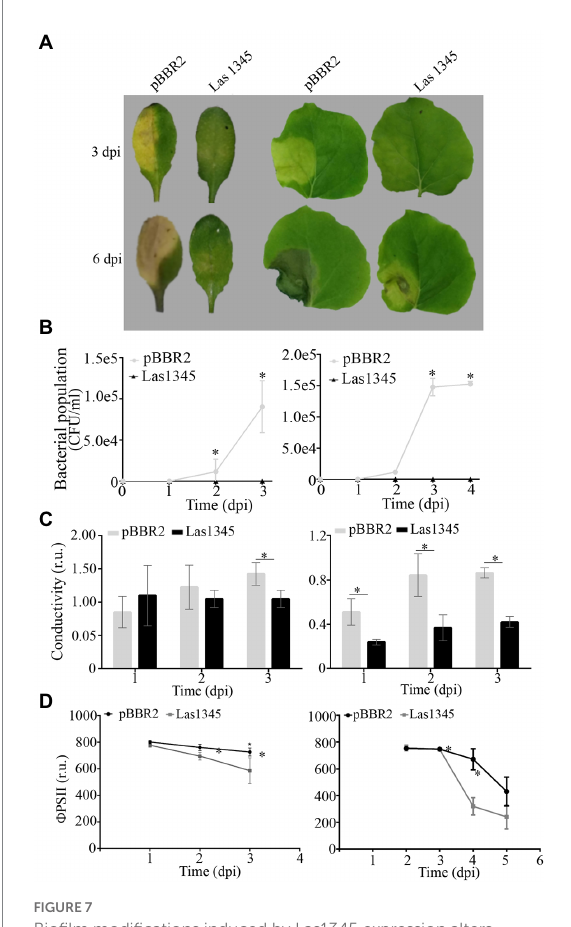
FIGURE 7 Biofilm modifications induced by Las1345 expression alters Xanthomonas campestris pv. campestris ( Xcc ) virulence. (A) Characterization of symptom development induced by Las1345-expresing Xcc in host plants. Infection of Arabidopsis thaliana and Nicotiana benthamiana with Xcc /Las1345 or Xcc / pBBR2 (10 7 CFU/ml) using pressure infiltration. Photos of disease symptoms were taken at different days post inoculation (dpi). (B) Bacterial population of Xcc transformants in N. benthamiana and A. thaliana leaves. Values are expressed as means ± standard deviation from five samples. Each sample was obtained from three leaf disks of 1 cm 2 from different inoculated leaves. (C) Quantification of cell death in leaves treated as described in (A) by measuring electrolyte leakage (conductivity) at different dpi. Values are expressed as means ± standard deviation from six samples. Each sample contains three leaf disks of 1 cm 2 from 10 inoculated leaves. (D) Photosystem II quantum efficiency ( ϕ PSII) were measured on inoculated leaf. Values are expressed as means ± standard deviation from 15 leaves. Asterisk indicates significant differences p < 0.05 (Student’s t